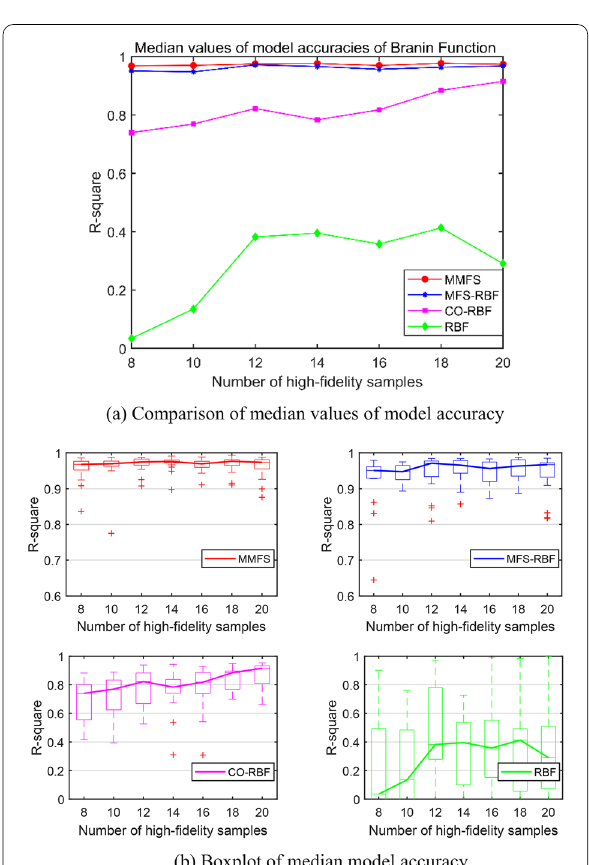
Figure 5 Comparison of median model accuracy of Branin function: a Comparison of median values of model accuracy, b box plot of median model